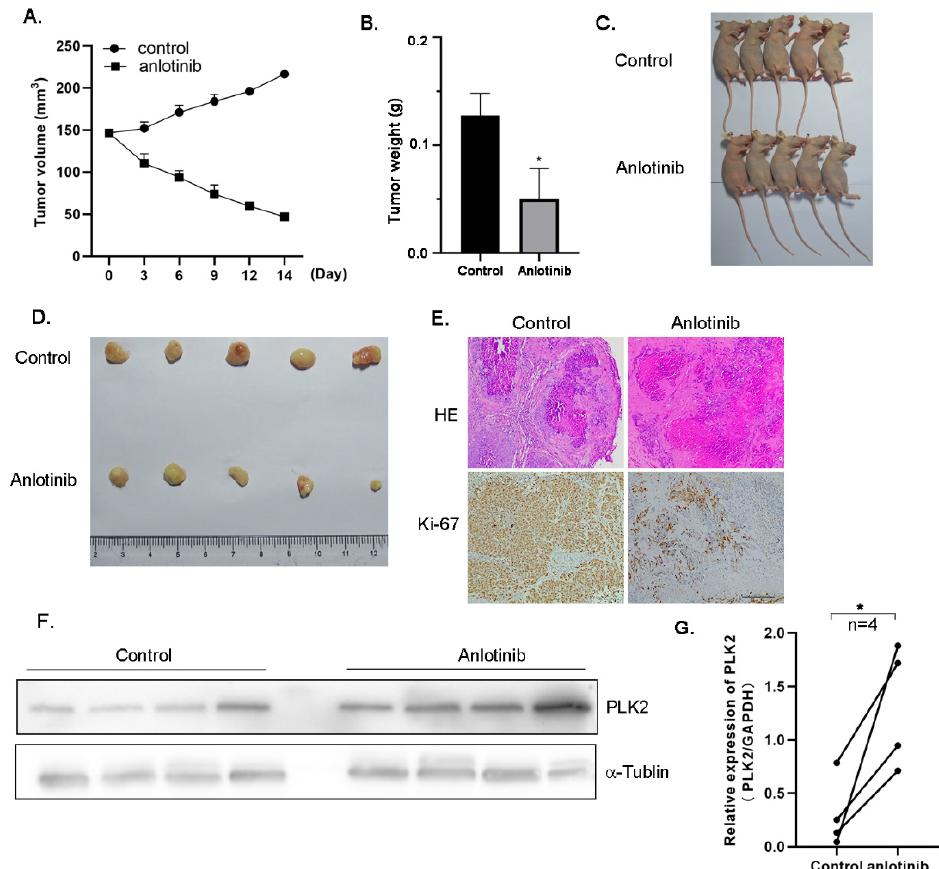
Figure 5. Anlotinib suppresses tumor growth in vivo. Mice ( n = 10) were intraperitoneally injected with saline or anlotinib (3 mg/kg/day) for 14 days, and the tumor size and bodyweight were monitored every two days. ( A ) Data are plotted as growth curves of the tumor volume and bodyweight. ( B – D ) The tumor samples were obtained and weighed after treatment with the drug. ( E ) Representative hematoxylin and eosin and immunohistochemical staining images of Ki67. ( F , G ) The expression of PLK2 was quantified via quantitative real-time polymerase chain reaction and Western blotting. All experiments were performed in at least three biological replicates, and each biological replicate contained three technical replicates. Student’s t -test was used to compare values between control and different treatment groups. * p < 0.05 indicates a significant difference compared to the control. Scale bars = 100 μ m.